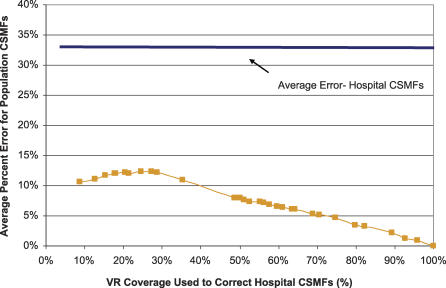
Population CSMFs Average Relative Error for 45 Cause GroupsARE was calculated as a function of the percentage of Mexican VR data used to assess the proportion of deaths in each age, sex, and cause group dying in hospital.